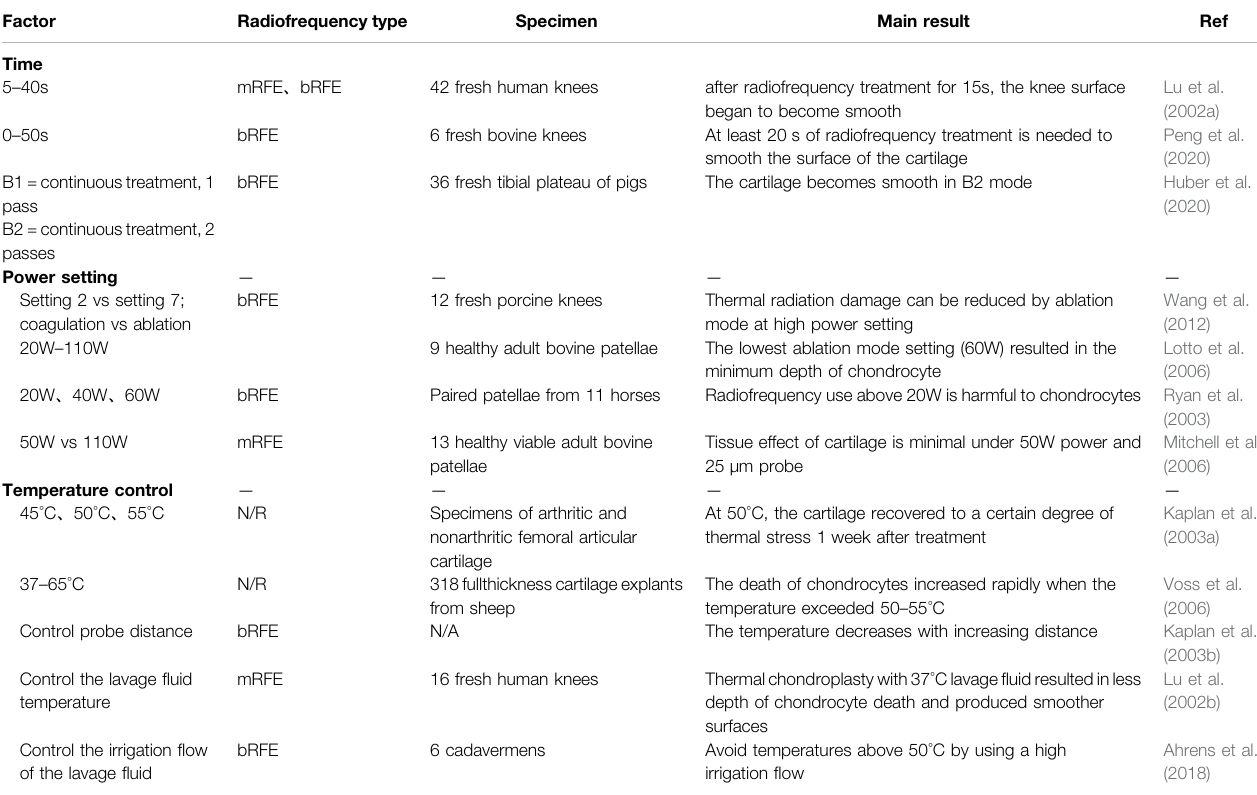
TABLE 1 | In fl uence of radiofrequency time, power setting, temperature control and lavage fl uid on articular